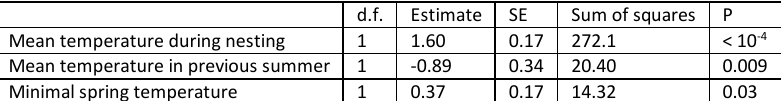
Table 3. Inter-annual variation in mean parasite load per chick (yearly average) in nests of blue tits infested by hematophageous Protocalliphora larvae, in relation to yearly average values of mean temperature during nesting, mean temperature in the previous summer, and minimal spring temperature. Results from the final linear model, obtained after forward selection from an initial set of models with valley, egg laying-date, ambient temperature during the nestling period, minimum, maximum, and average ambient temperature and total rainfall during each preceding season as explanatory variables, as well as interactions between valley and all other covariates. d.f. Estimate SE Sum of squares P Mean temperature during nesting 1 1.60 0.17 272.1 < 10 -4 Mean temperature in previous summer 1 -0.89 0.34 20.40 0.009 Minimal spring temperature